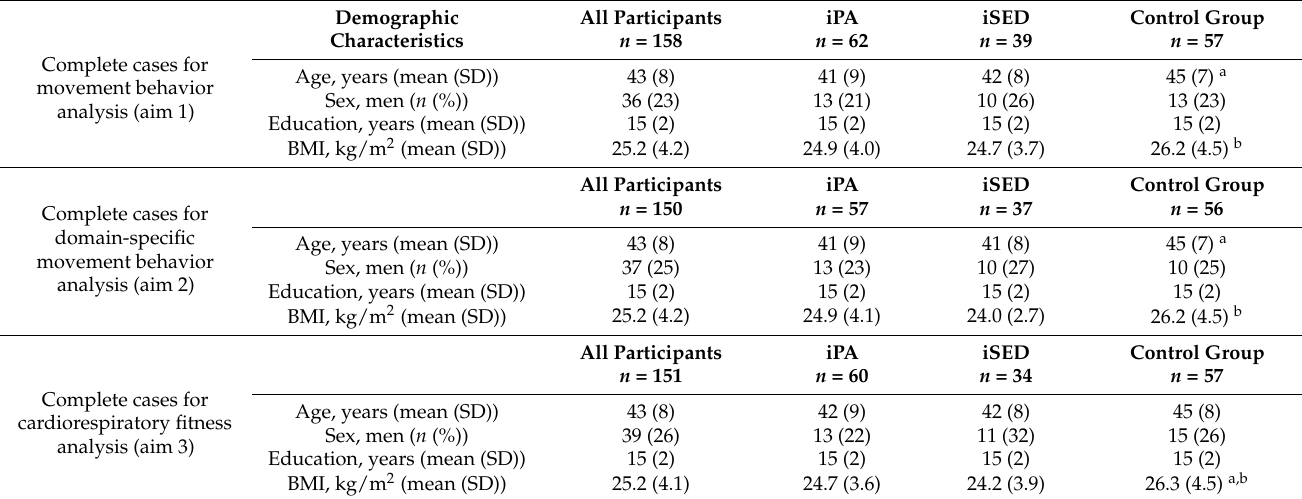
Table 1. Participants’ baseline characteristics for the three analytic